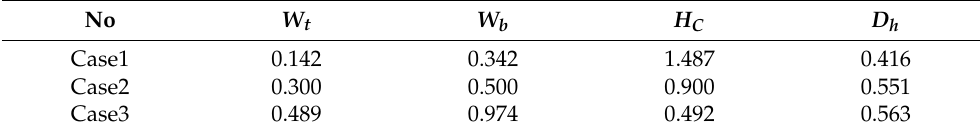
Table 4. Parameters of trapezoidal microchannel heat sinks ( A C = 0.36 mm 2 unit: mm).